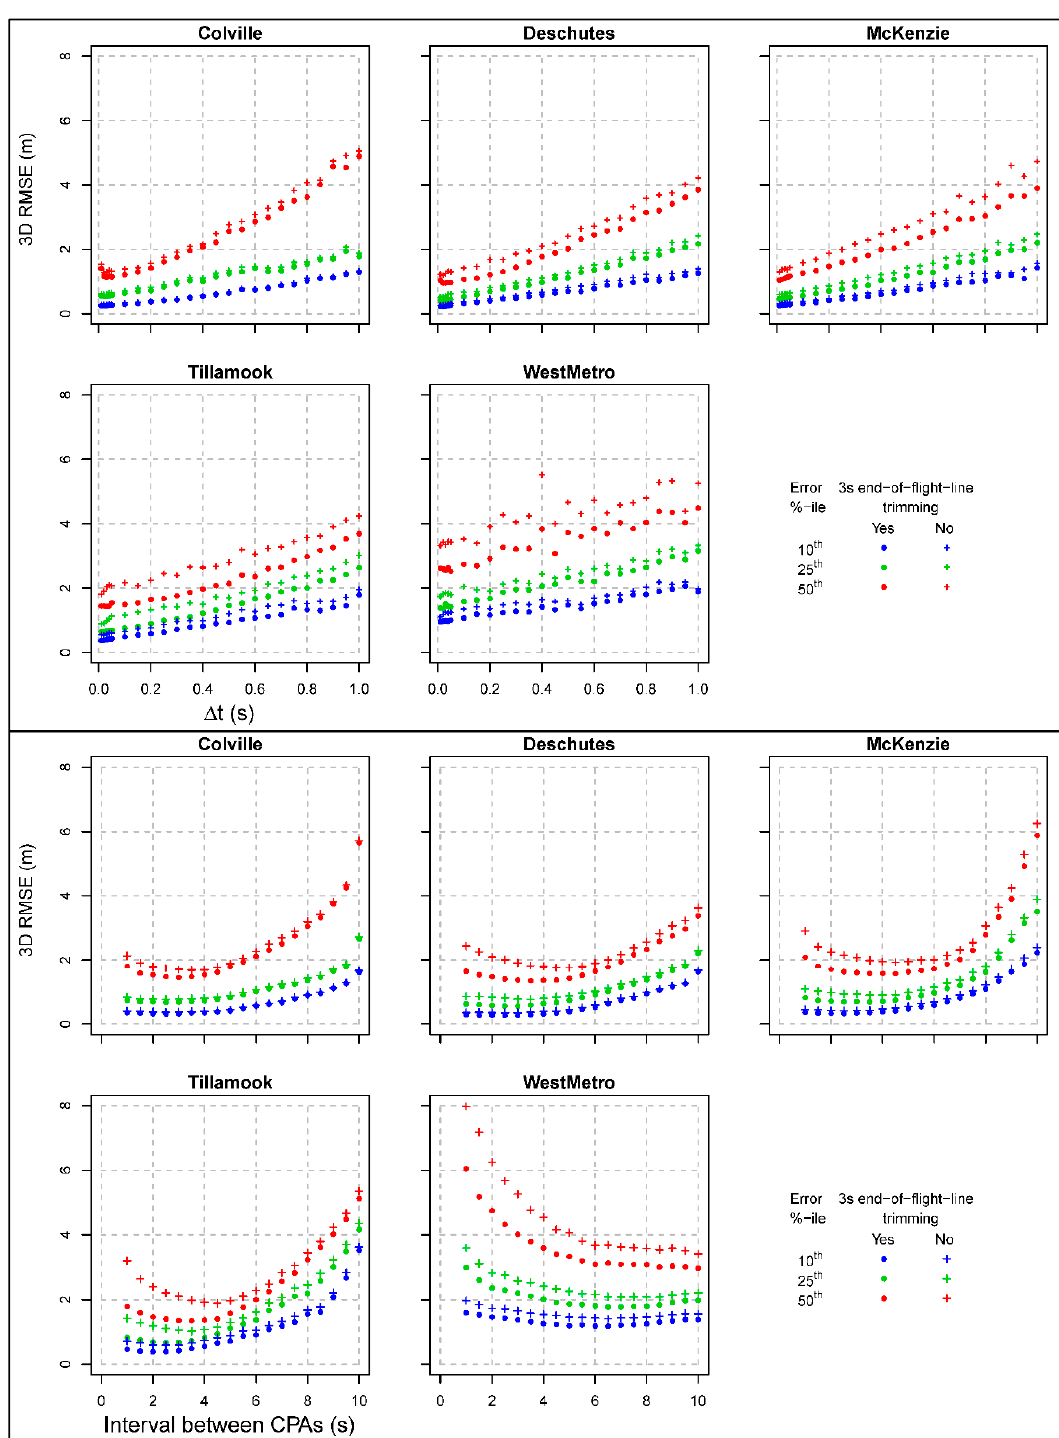
Figure 7. Distribution of error percentiles in splines fit to flight line-specific CPA sets across study areas as function of time block duration (top) and time intervals between CPAs used in the fitting (bottom), calculated using recorded platform positions. Crosses indicate the entire CPA set was used for each flight line; dots denote CPAs trimmed by 3 seconds on either end, to reduce effects induced by acquisition boundaries.